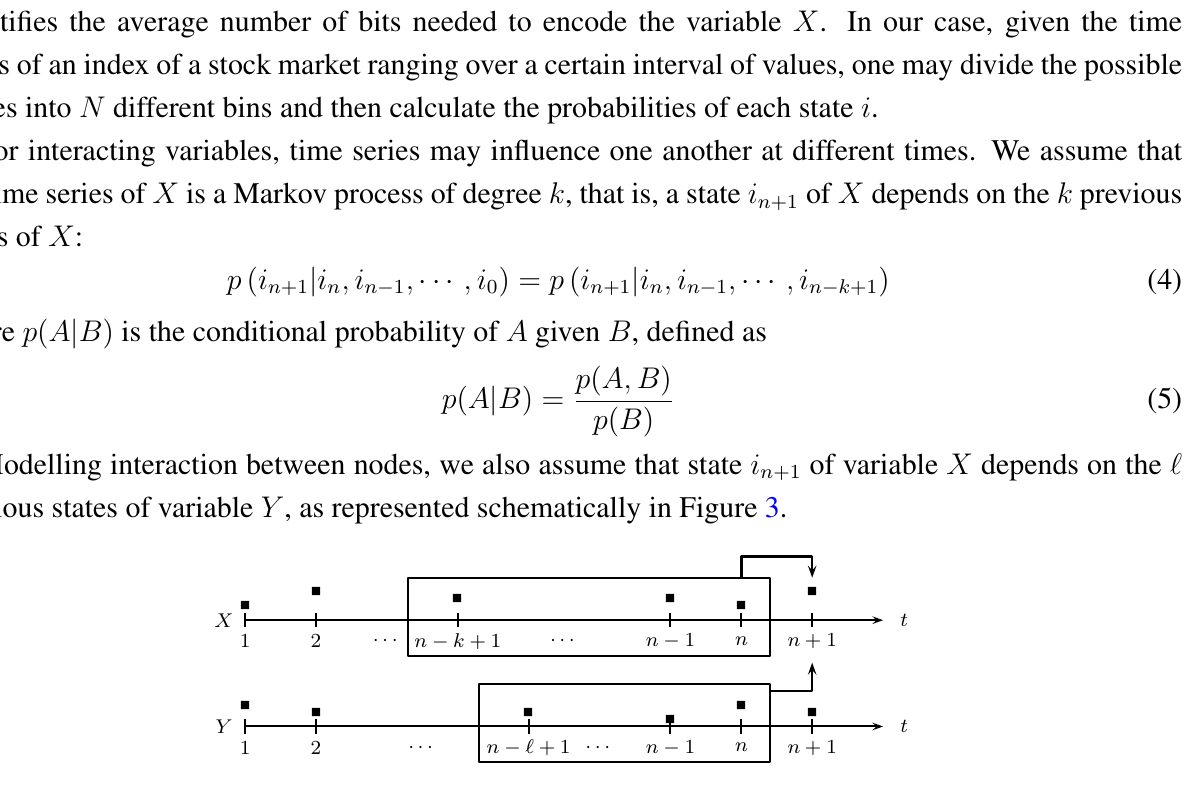
Figure 3. Schematic representation of the Transfer Entropy between a variable Y and a variable X